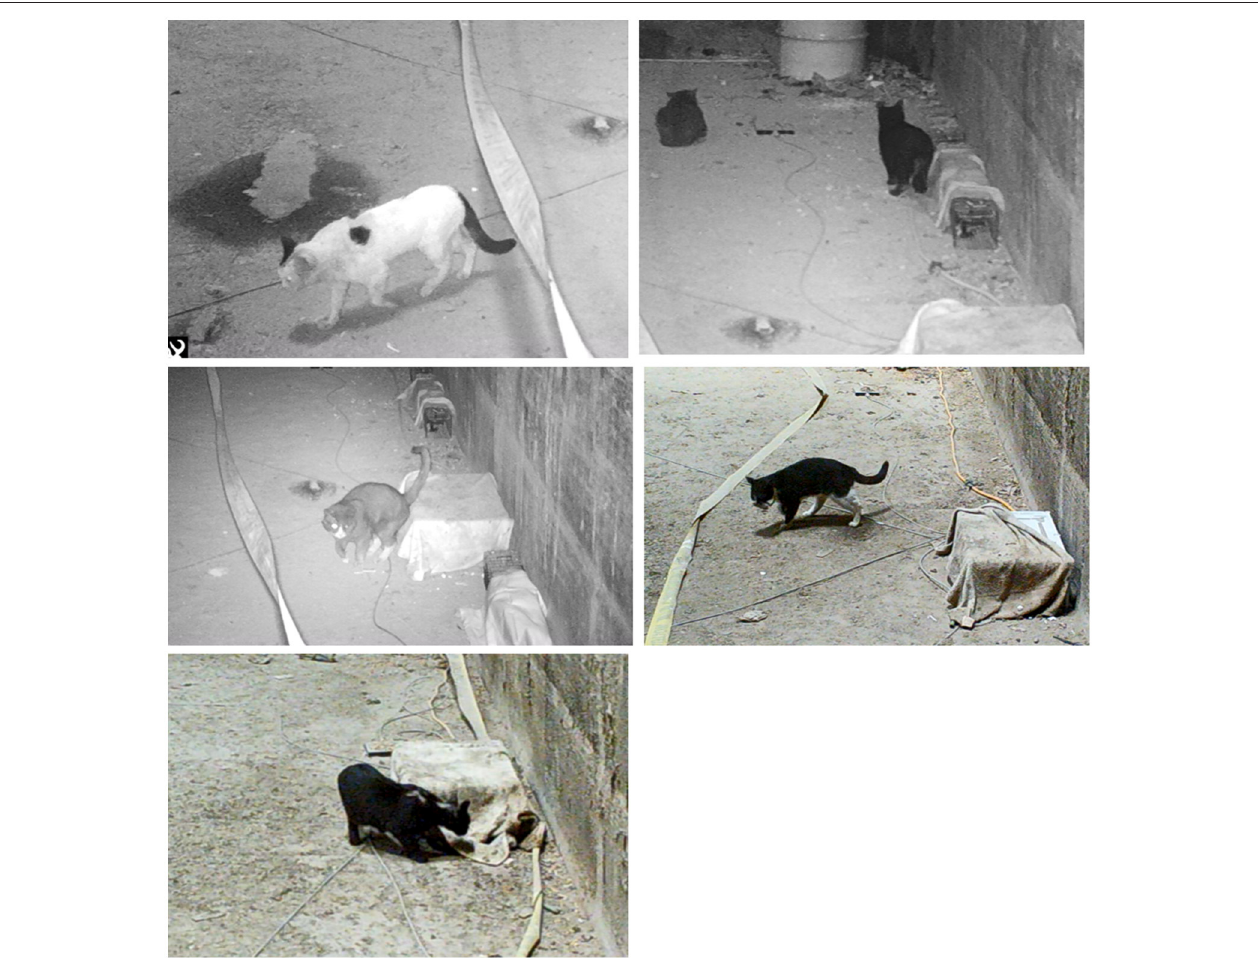
FIGURE 2 | Coat patterns of five feral cats and subsequent ethogram used to score their behaviors at a semi-enclosed industrial building in New York City from Dec. 27, 2017—May 28, 2018. Cat behaviors scored (modified from Stanton et al., 2015) include walking (w): forward locomotion where animal moves slowly. Running (r): animal uses forward locomotion at a rapid gait. Stalking (s): slow forward motion in crouched position, with head low and eyes focused on potential prey. Predation (p): hunting or killing that leads to a direct kill. Sniffing (s): cat smells floor or object by inhaling air through the nose. Feeding (f): animal ingests food, usually from floor. Sitting (s): animal is immobile in upright position. Marking (m): while standing with tail raised vertically, cat releases jet of urine backwards onto a substrate of an object. Tail may quiver as urine is released.